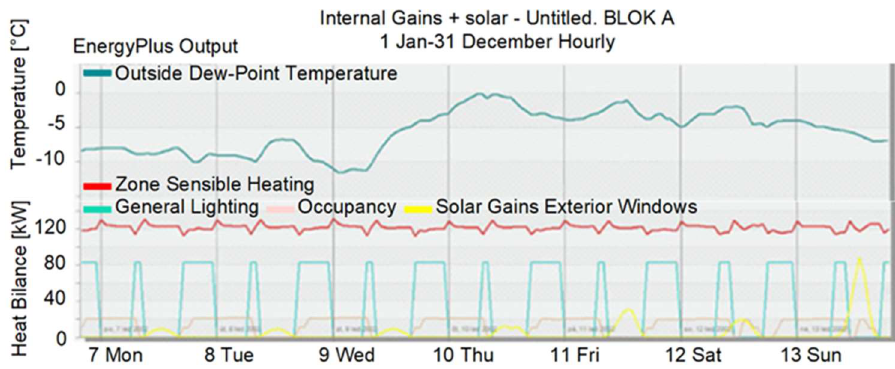
Figure 15. Heat balance of Block A after the reconstruction in winter (weekly section). Table 8. Heat demand before reconstruction.